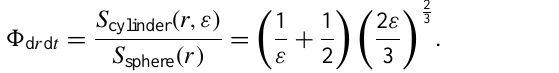
The correction factors (cid:56) d r d t and (cid:56) sedi are shown in Fig. 2.